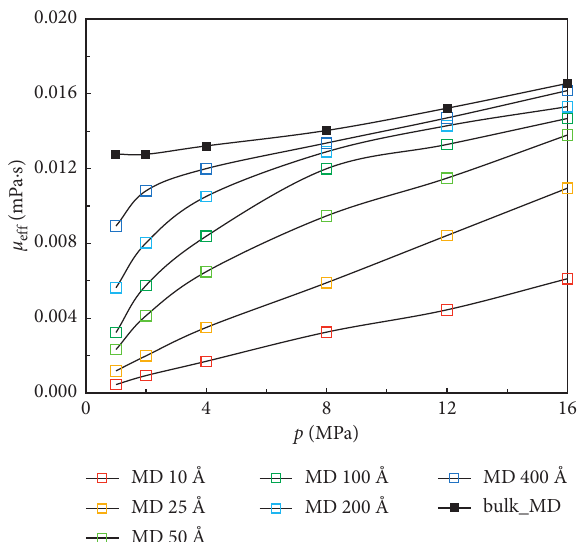
Figure 5: The gas viscosity in the slit pore with pressure for different width pores at 343.15K (the symbols denote the viscosity of methane in organic slit nanopore. Lines are drawn as a guide to the eye.).